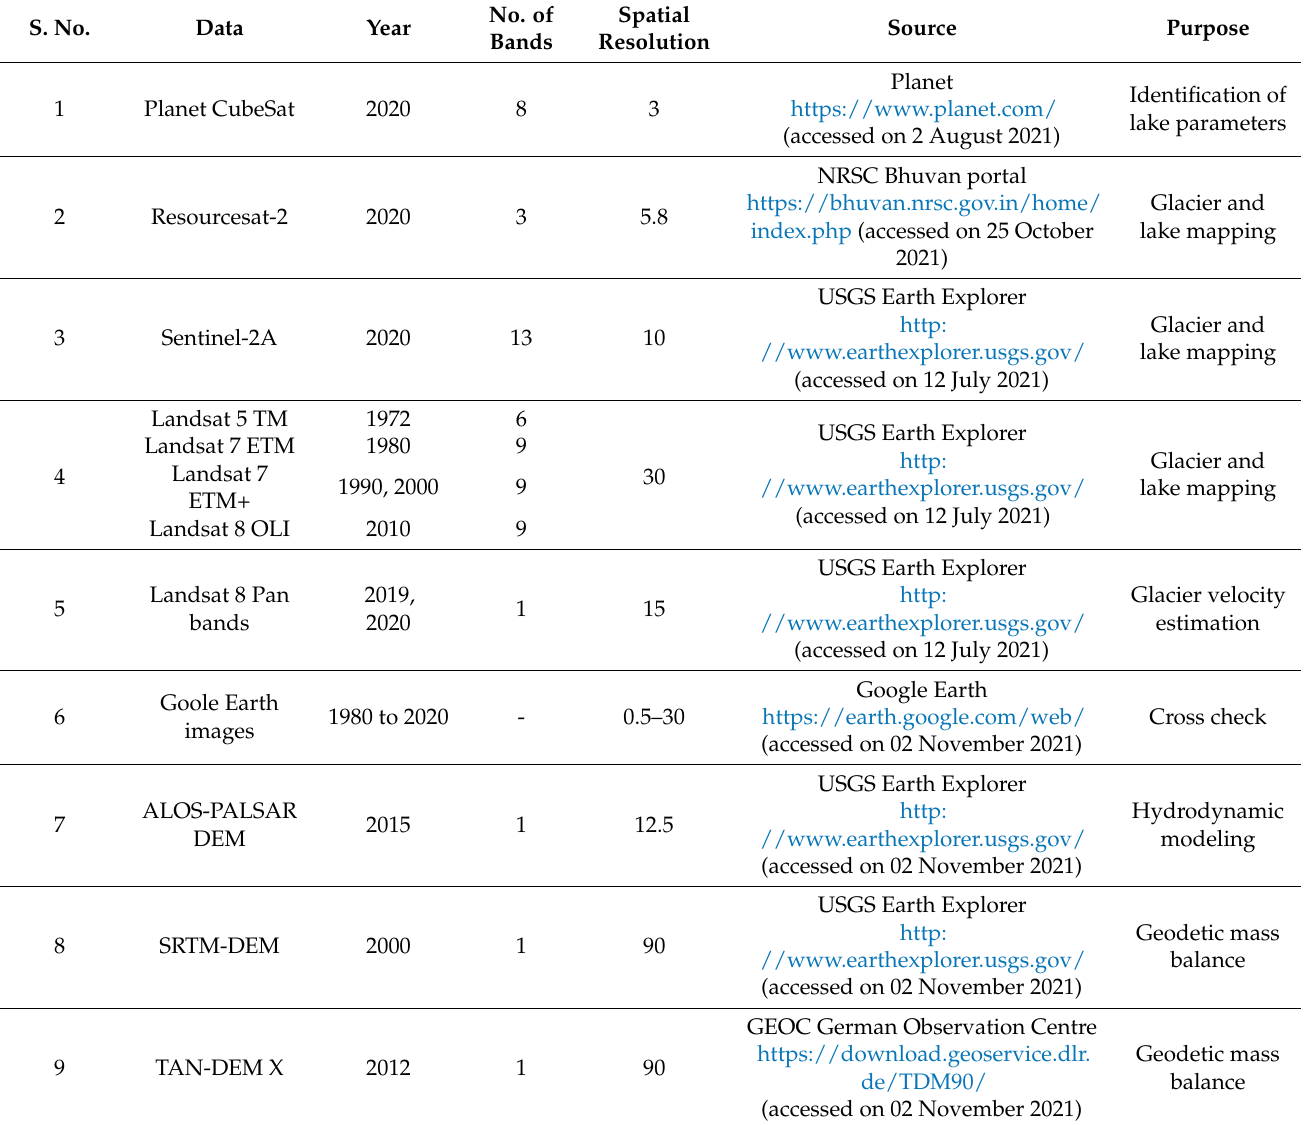
Table 1. Data sets used in the